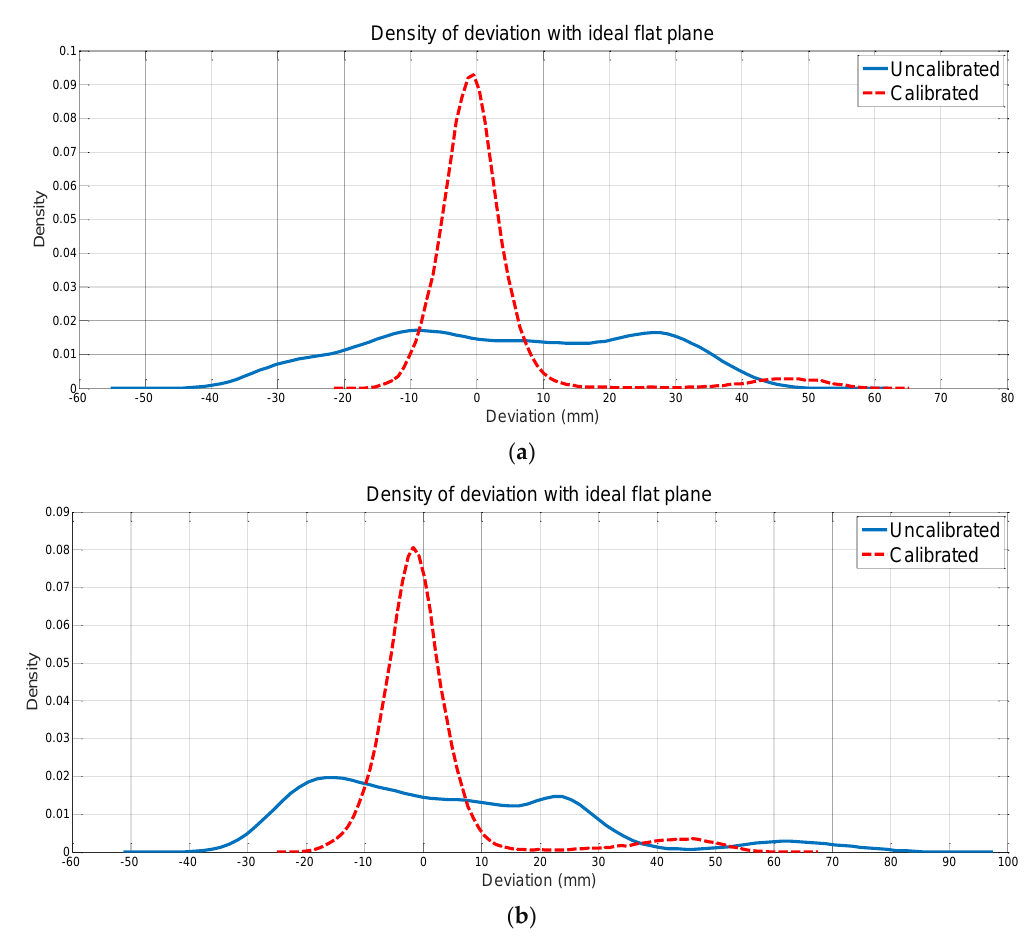
Figure 11. ( a , b ) are the deviation comparisons of scan_front and scan_followed, respectively. The bias angle was estimated from scan_front. The deviation under calibration condition in ( a ) is mainly ranging from −15 mm to 15 mm and the deviation under calibration condition in ( b ) is mainly ranging from −20 mm to 15 mm. Both deviations after calibration were greatly decreased compared to the uncalibrated condition.